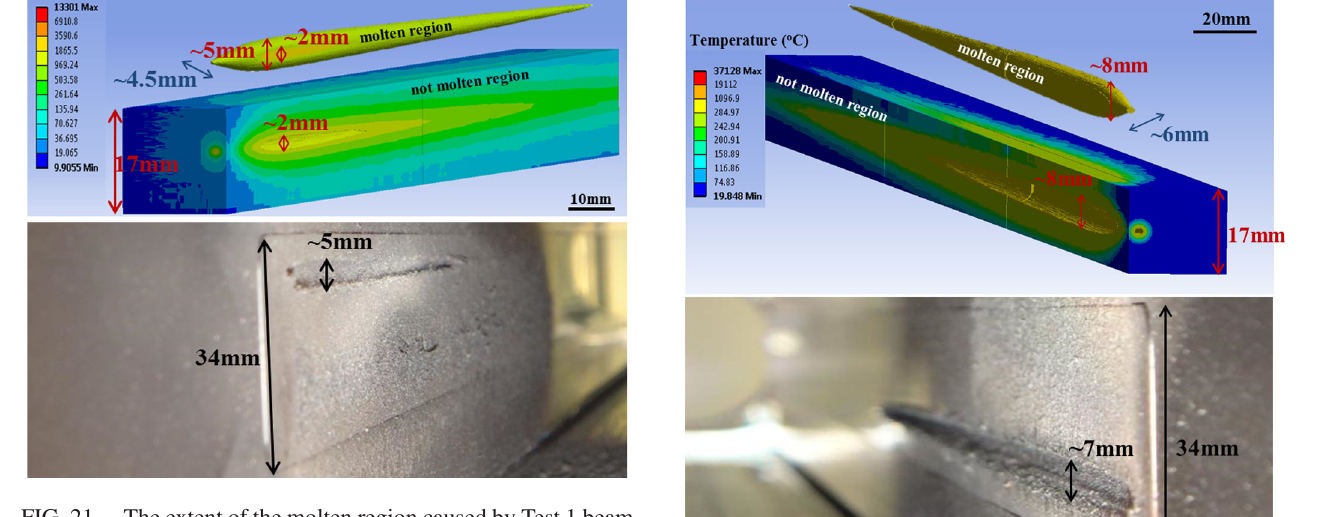
FIG. 21. The extent of the molten region caused by Test 1 beam impact, resulting in a groove on the top half of the first Inermet 180 jaw insert block, as simulated by ANSYS ® on the left jaw. At region inside the jaw insert extends also to the second insert block. Marked dimensions of the grooves only take into account the estimated height of the groove.